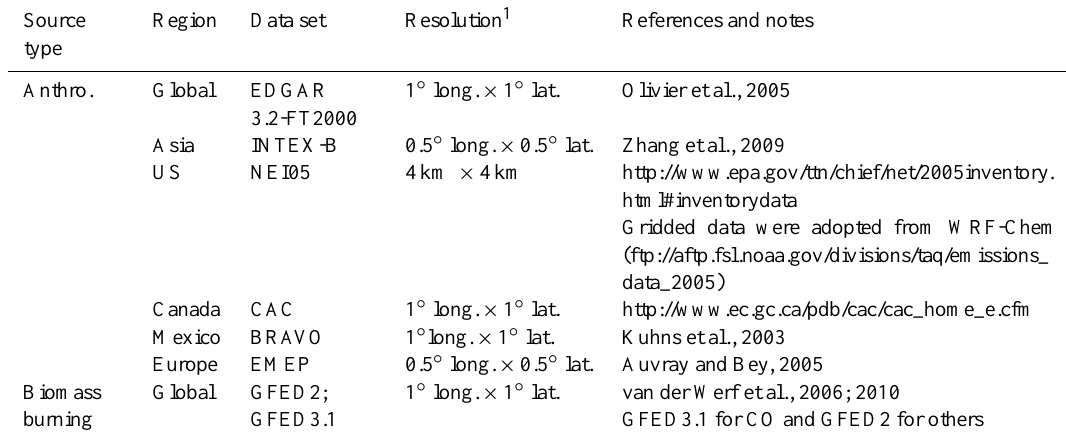
Table 1. Anthropogenic and biomass burning emission inventories used by GEOS-Chem.